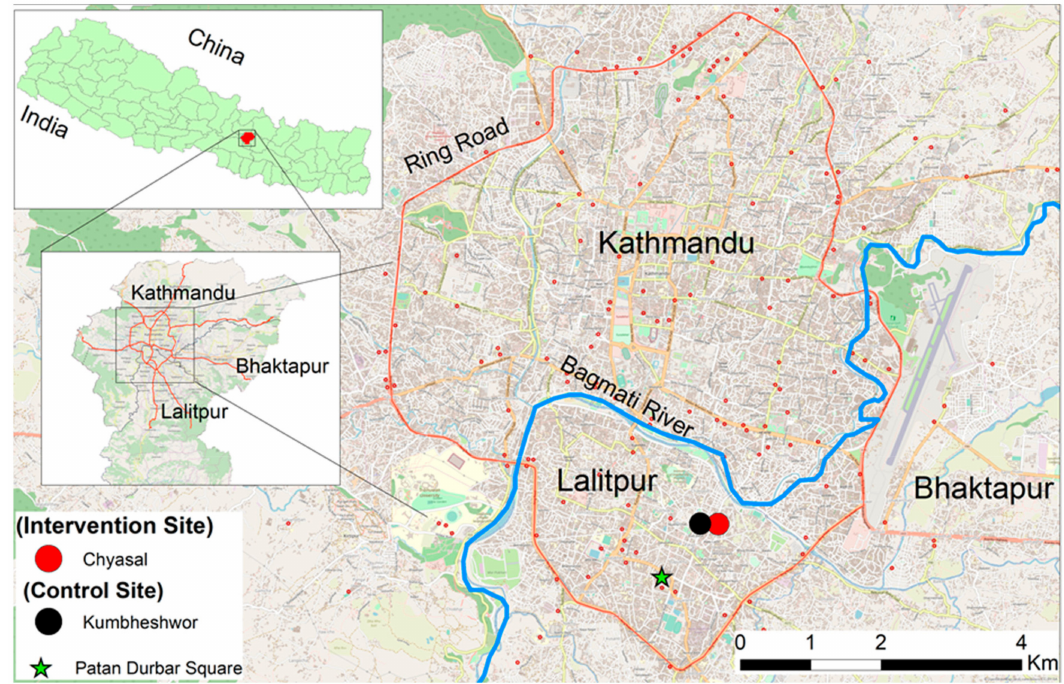
Figure 1. Location of intervention (Chyasal) and control (Kumbheshwor) sites in the Kathmandu Valley.